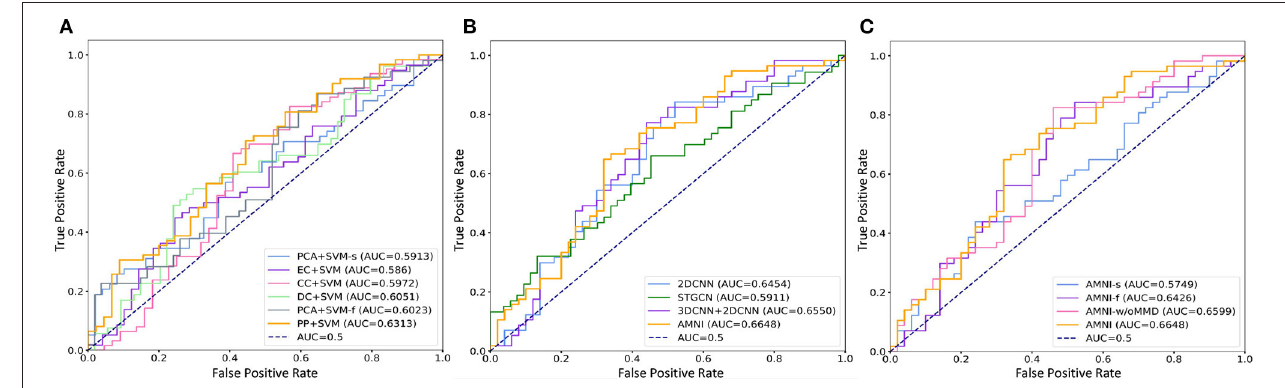
FIGURE 2 | ROC curves and related AUC values achieved by different methods in MDD vs. HC classification. (A) AMNI vs. six conventional methods. (B) AMNI vs. three deep learning methods. (C) AMNI vs. its three variants.